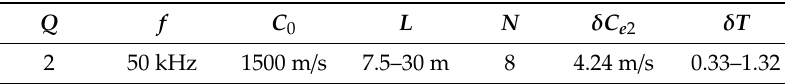
Table 1. Parameters of resolution